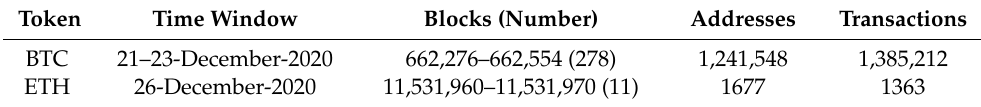
Table 9. Transaction data downloaded for BTC and ETH complex network